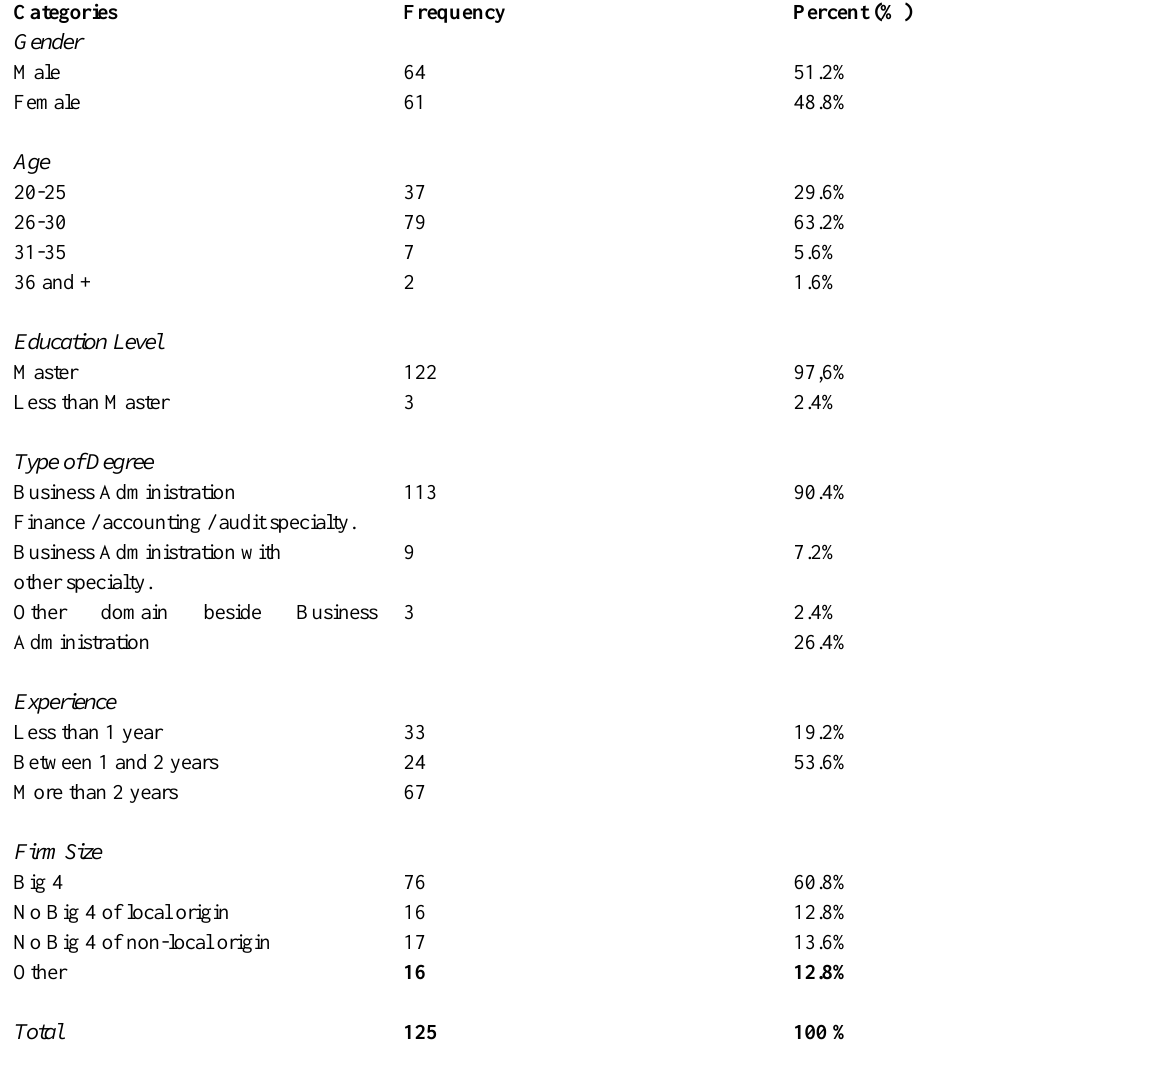
Table 1: Demographic profile of